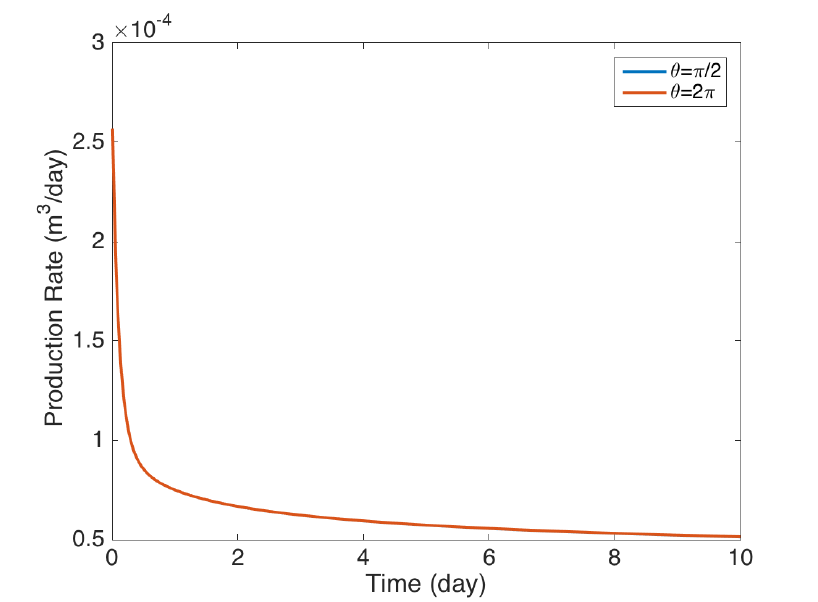
Figure 11. The production rate for various values of the parameter θ